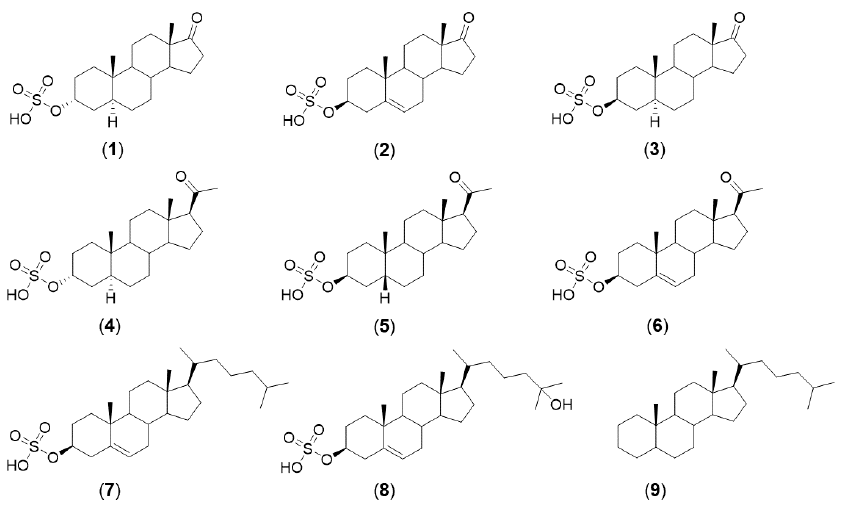
Figure 2. Overview of the model analytes: 1 androsterone sulfate, 2 dehydroepiandrosterone sulfate, 3 epiandrosterone sulfate, 4 allopregnanolone sulfate, 5 pregnanolone sulfate, 6 pregnenolone sulfate, 7 cholesterol sulfate, 8 25-hydroxycholesterol sulfate, and 9 cholestane (internal standard, IS).